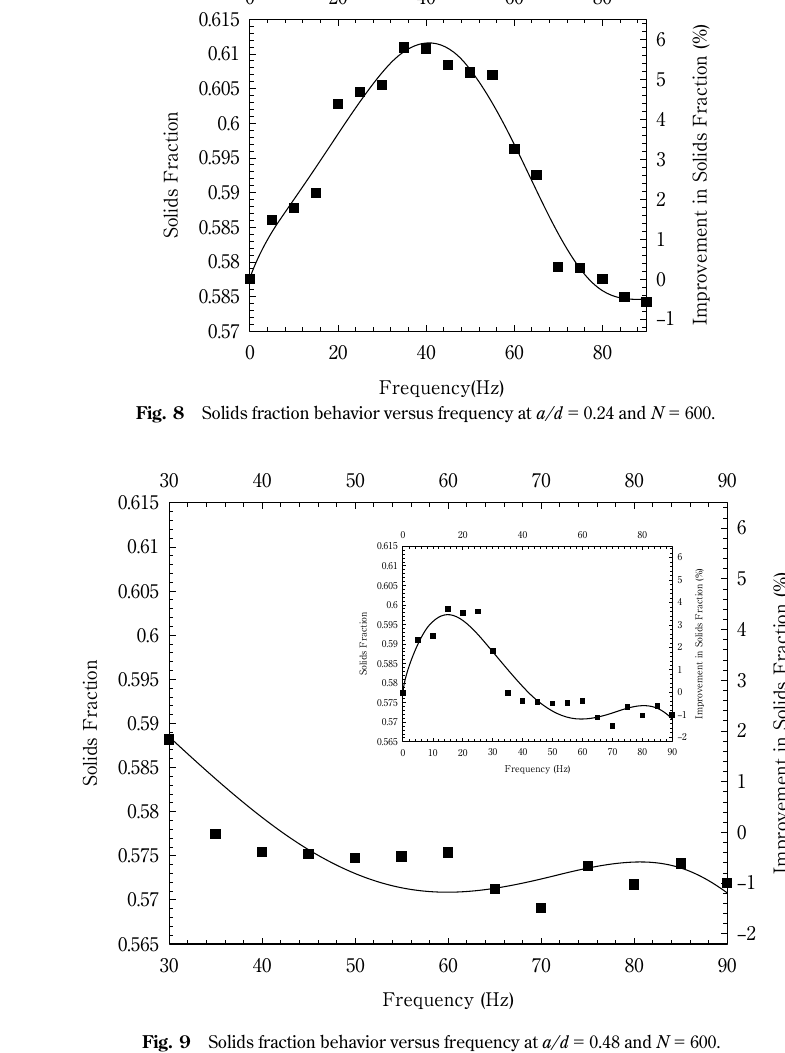
Fig. 9 Solids fraction behavior versus frequency at a/d = 0.48 and N =